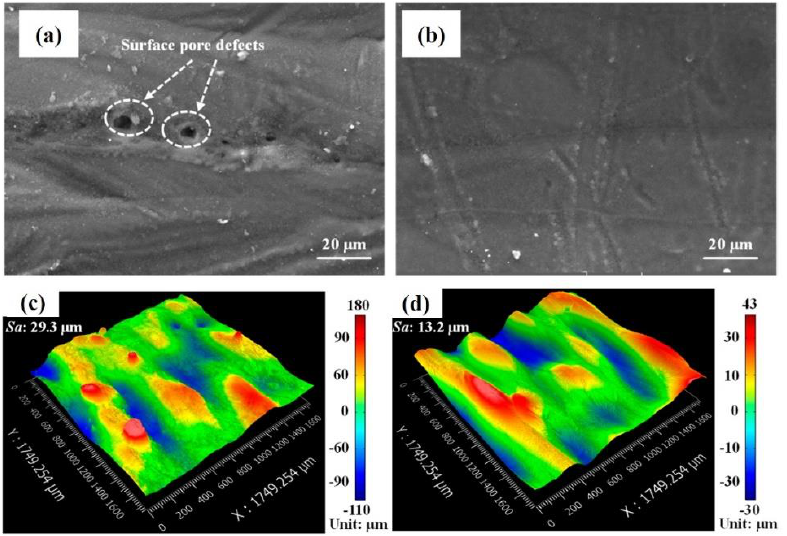
Figure 16. ( a , b ) SEM images of AlSi10Mg alloy before and after laser polishing, and ( c , d ) morphol- ogies of AlSi10Mg alloy before and after laser polishing [84]; published under MDPI open-access license.